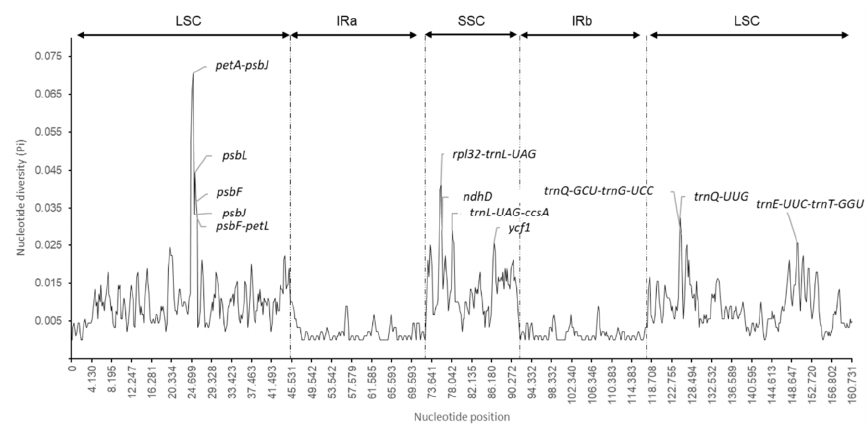
Figure 5. Nucleotide diversity (Pi) values for the whole chloroplast genomes of A. spinosa , S. wightianum , and P. campechiana species using a window length of 600 bp and a step size of 200 bp.